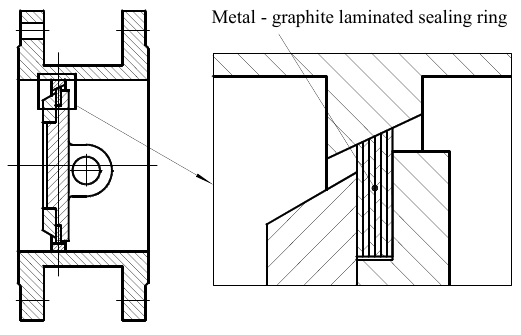
Figure 3. Metal-graphite laminate seal structure.